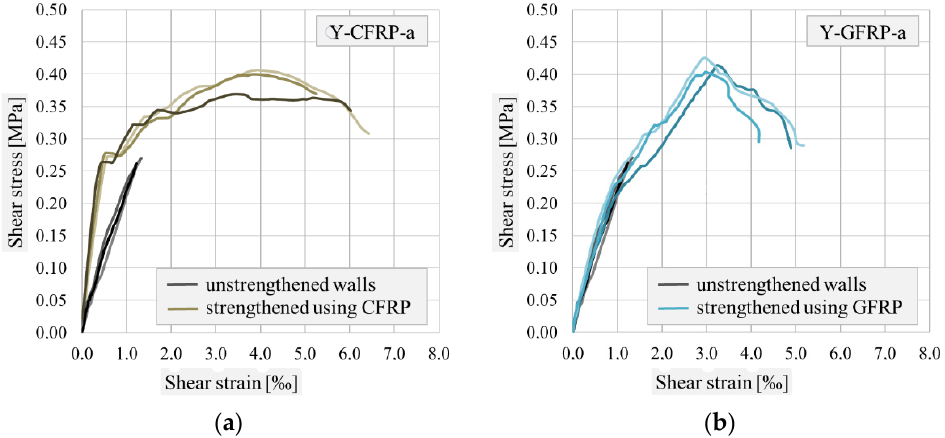
Figure 5. The stress–strain relationships for the wallets strengthened in configuration ‘a’ and un- strengthened walls: ( a ) the elements with carbon strips; ( b ) the elements with glass strips.